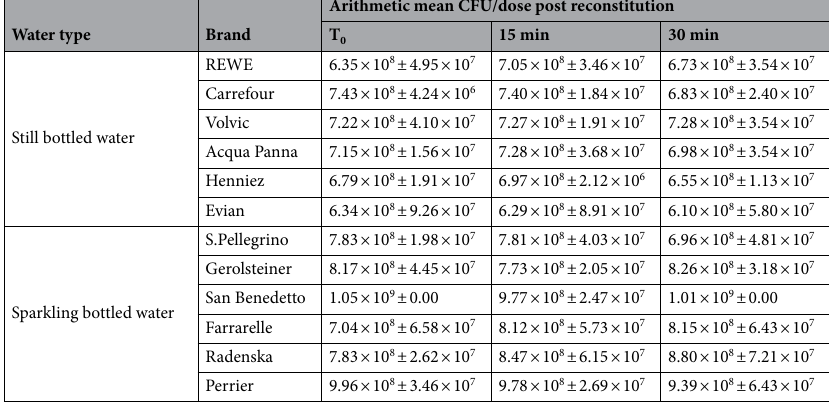
Sparkling bottled water